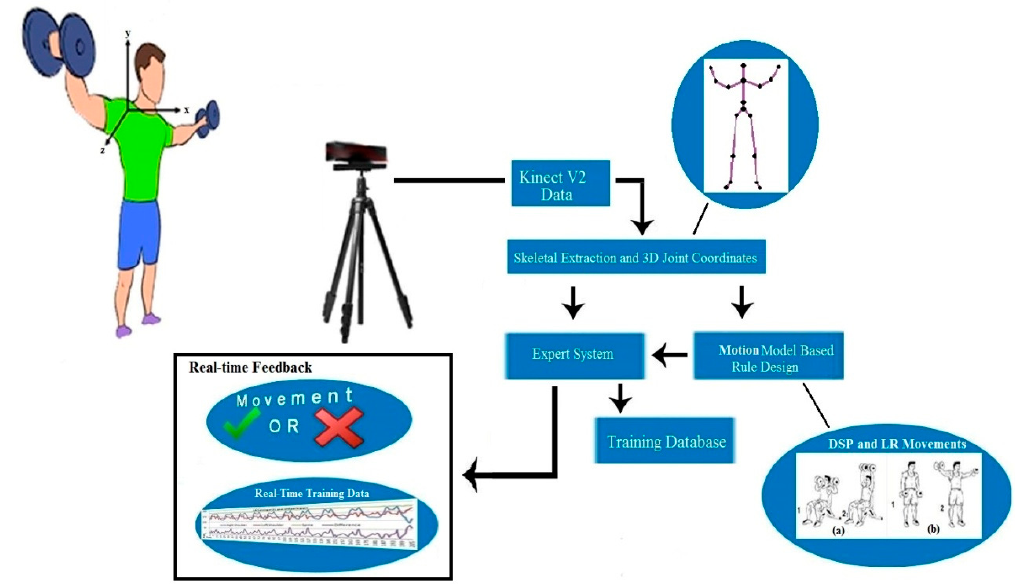
Figure 1. Example view of the proposed system.